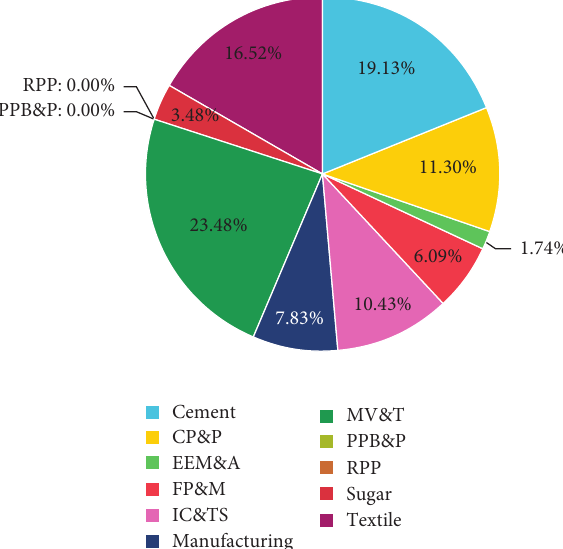
Figure 6: Decomposition of financial expertise (professional certification) in equity market.